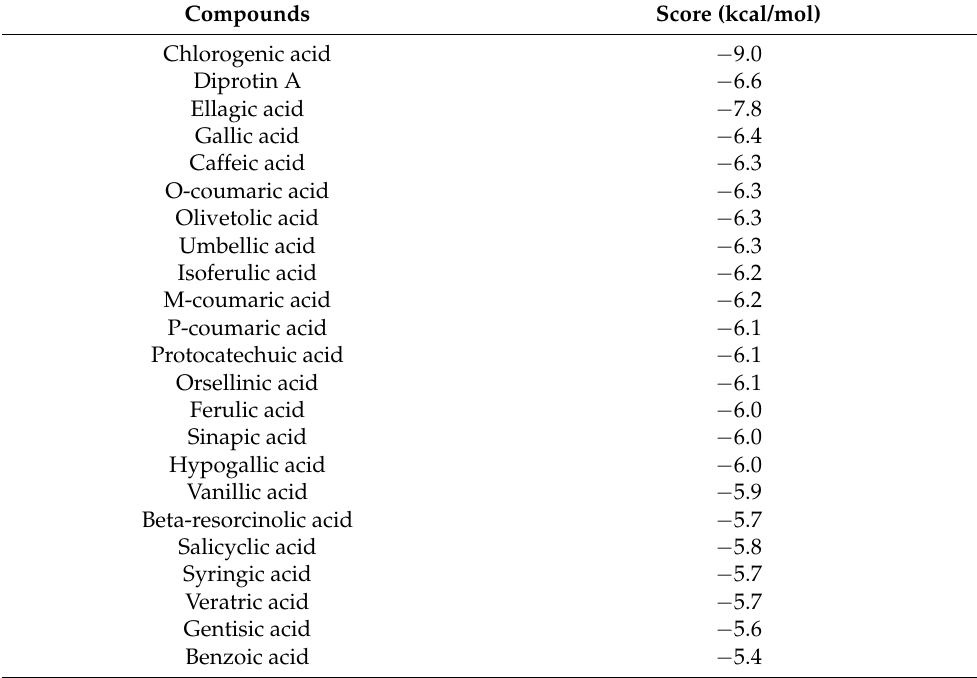
Table 1. Binding energy scores of phenolic acids and dipeptidyl peptidase-IV